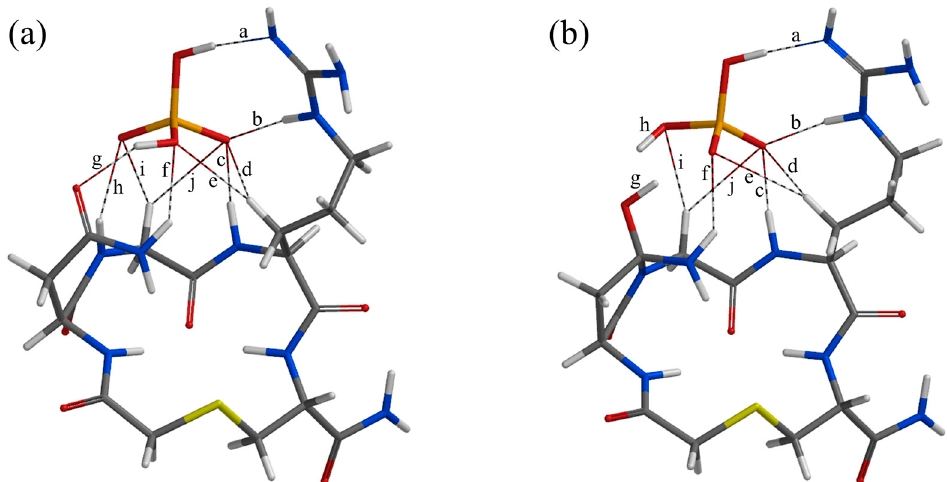
Figure 4. The ten-point interaction (interactions a–j) in RC* (reactant complex) ( a ) and the corresponding interactions (including two O–H covalent bonds (g and h) in IC1* (intermediate complex 1)) ( b ). The corresponding interatomic distances are shown in Table 1. Grey: carbon; white: hydrogen; blue: nitrogen; red: oxygen; orange: phosphorus; yellow: sulfur. These geometries can be reproduced from the Cartesian coordinates reported previously [67].